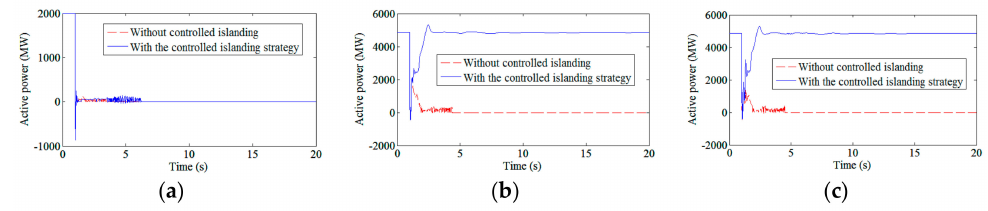
Figure 13. DC power on high voltage direct current (HVDC) lines. ( a ) HVDC Line 1; ( b ) HVDC Line 2; ( c ) HVDC Line